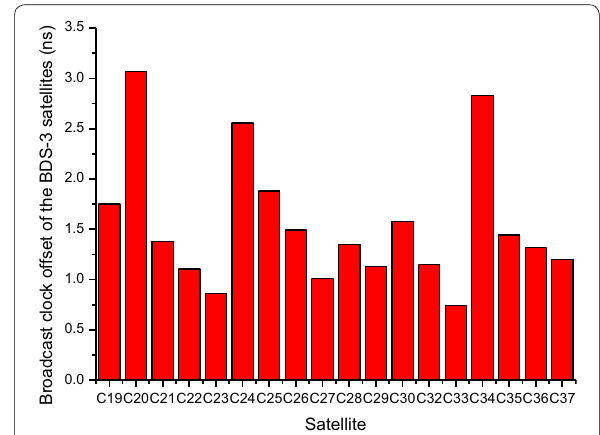
Fig. 2 Broadcast clock offset of the BDS-3 satellites